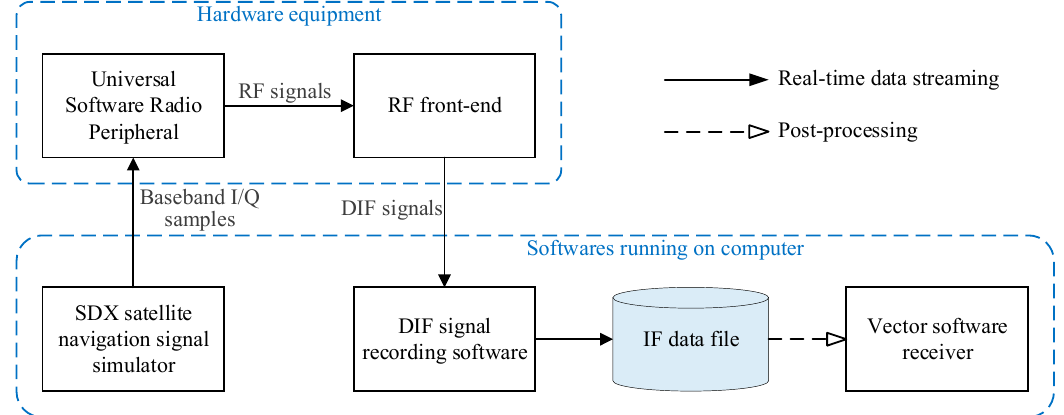
Figure 4. Simulation experiments data generation and processing flow.